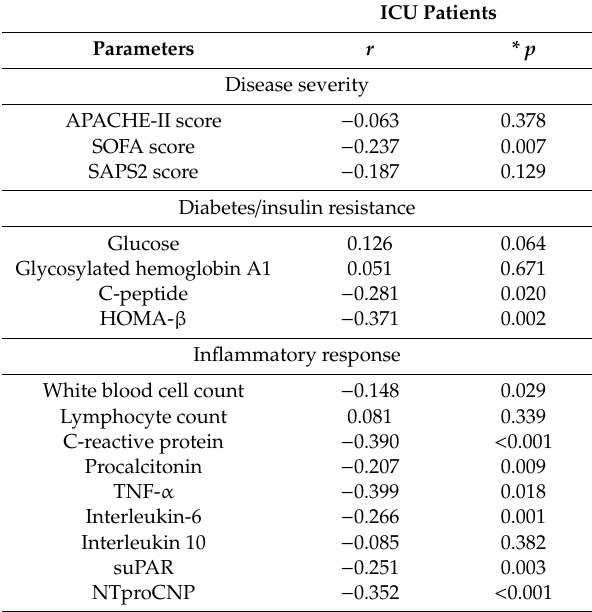
Table 3. Correlations with CTRP3 plasma concentrations at ICU admission (Spearman rank correlation